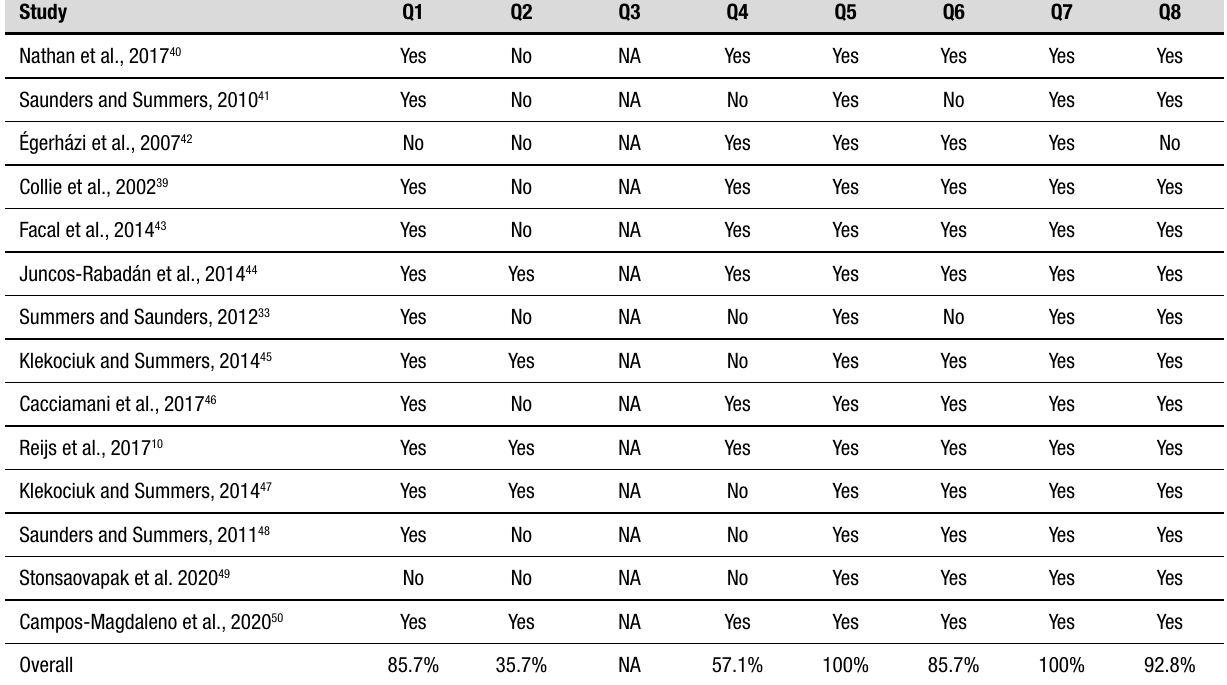
Table 2. Results of risk of bias assessment.